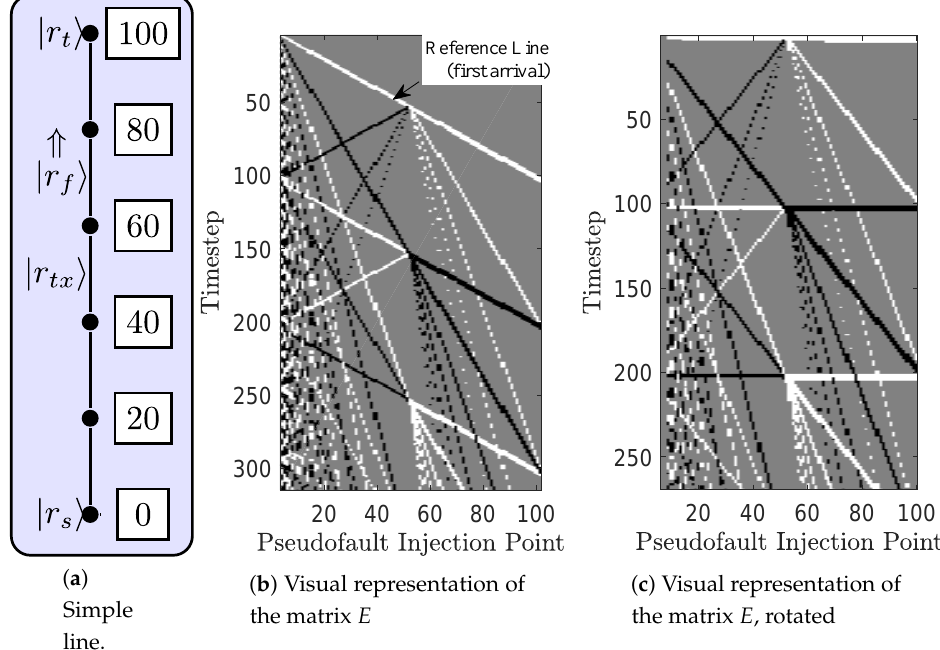
Figure 1. A pseudofault impulse is injected into the line at 1 m intervals at position r f and a simulation performed to determine the associated response at the source for each injection point. The terminations r s and r t are assumed to be open circuit ( Γ = 1). When the observed signal at the source exceeds a positive threshold, it appears as white, while a signal which is less than a negative threshold appears as